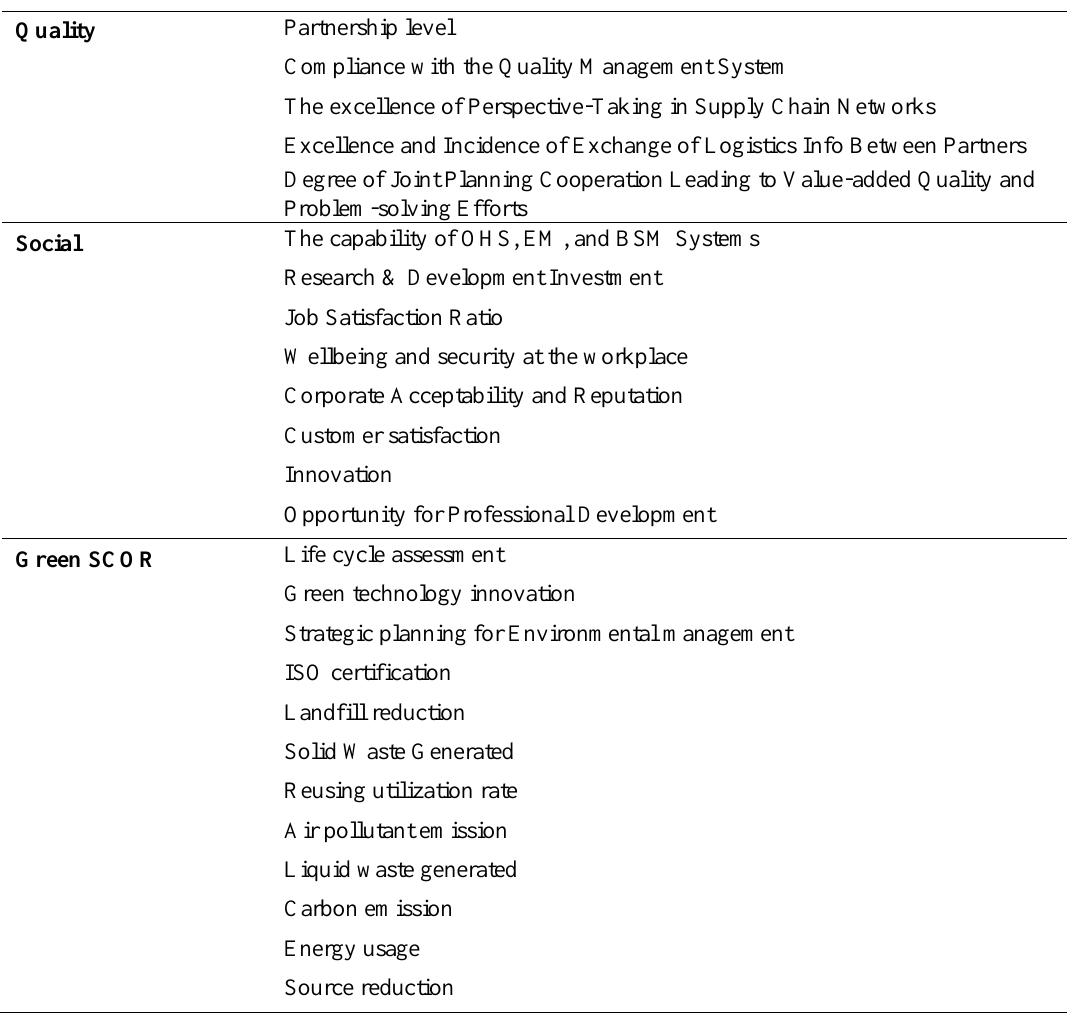
Table 3. The Affiliation between the New Supply Chain Operation Reference Measures with the Procedure and Characteristics of Existing Supply